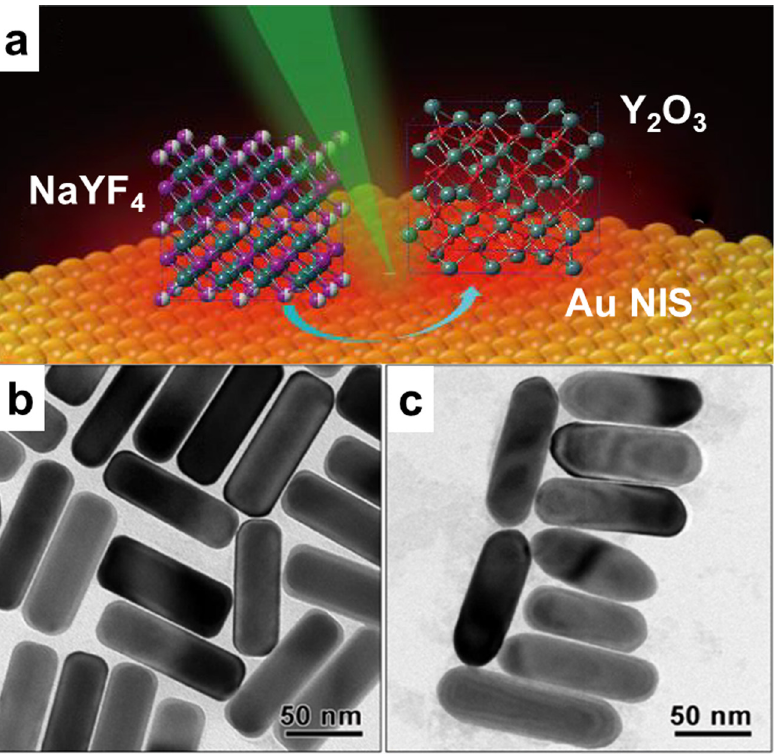
Figure 7: ( a ) Schematic of the fast transformation of RE 3 + - doped luminescent crystals with plasmonic Au NIs. Reproduced with permission [ 152 ] . Copyright 2020, Royal Society of Chemistry. ( b and c ) TEM images of original Au@Ag NRs - 2.5 and fully alloyed AuAg NRs -